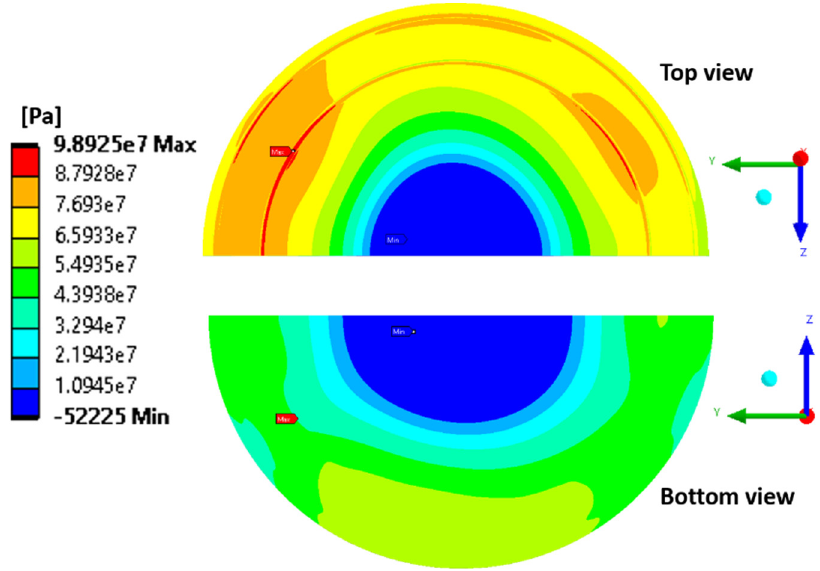
Figure 8. First principal stress distribution in the diamond disk for the reference